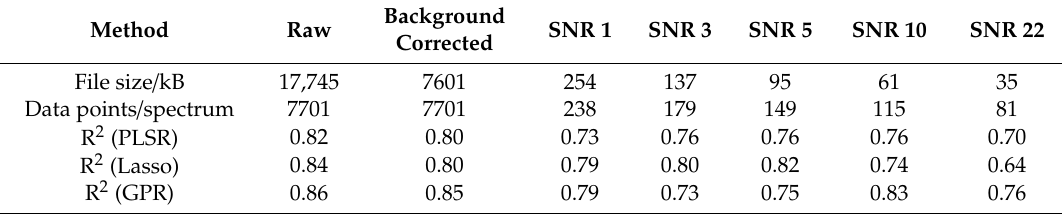
Table 5. E ff ect of data reduction for di ff erent signal-to-noise ratios (SNR) on coe ffi cients of determination obtained for the Ca mass fraction for the three multivariate methods PLSR, Lasso and GPR, application to 137 spectra